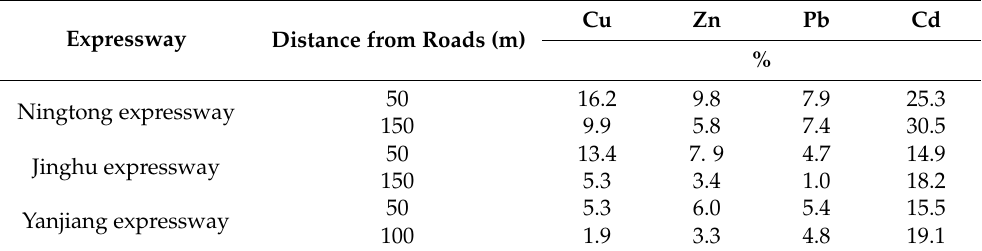
Table 6. Anthropogenic contribution ratios of heavy metals in the surface 30 cm soils in the vicinity of